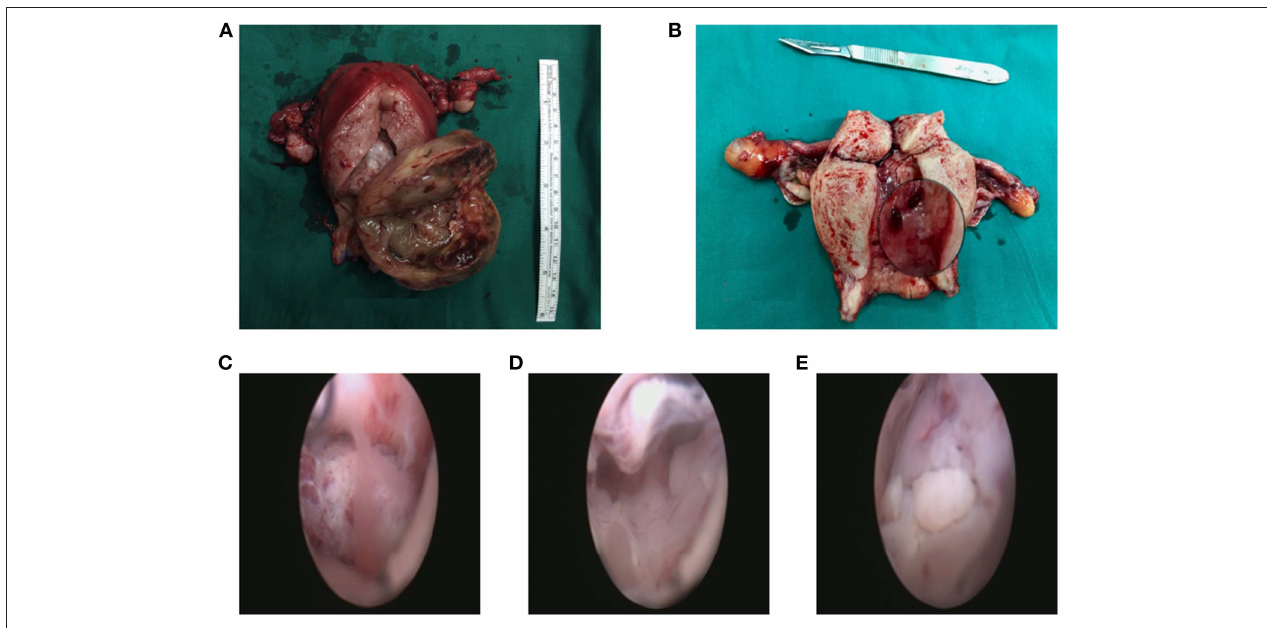
FIGURE 1 | The tumor with a stalk to the uterine (A) . The residual stalk root after tumor resection (B) . Extensive lesions without a stalk (C–E) .